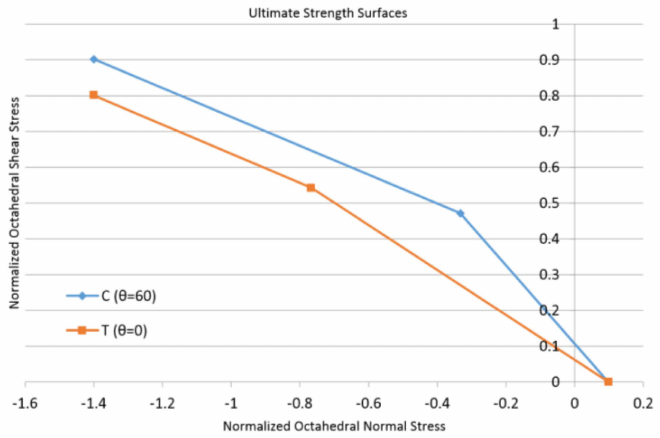
Figure 10. Recalibrated ultimate strength surfaces C and T.